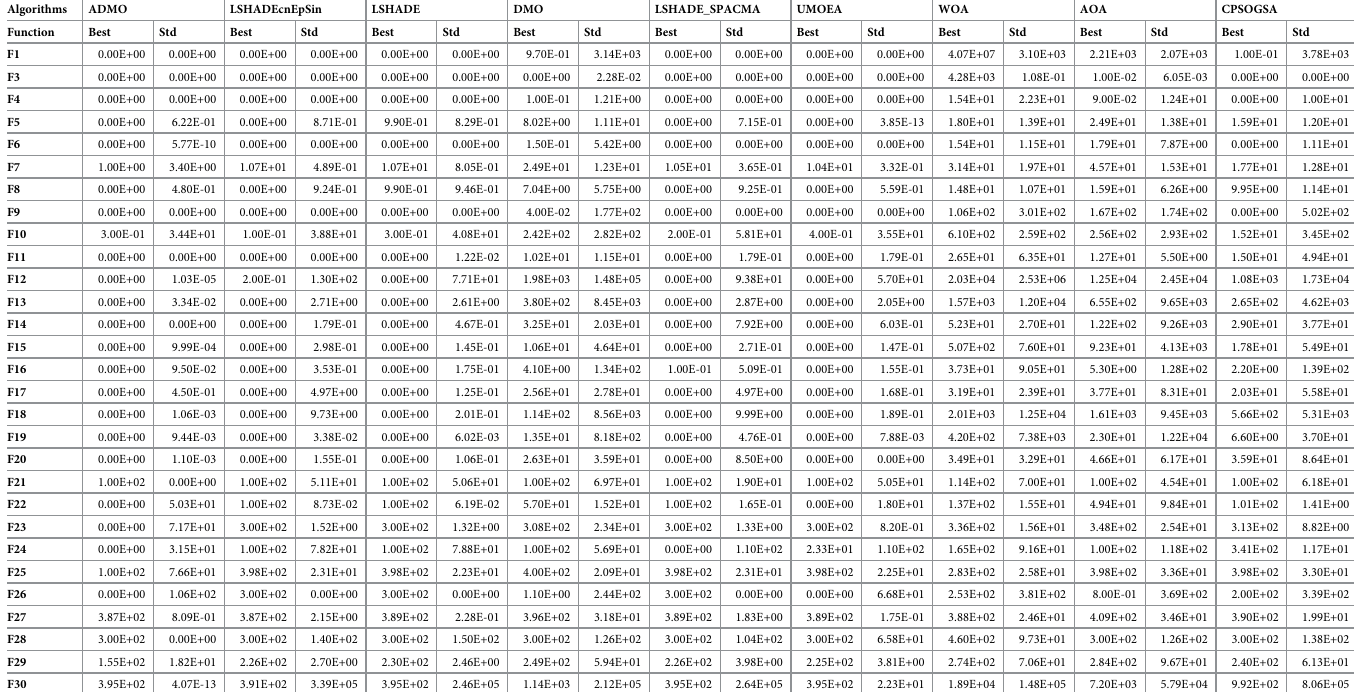
Table 10. Comparative results for 10 dimensions. Algorithms ADMO